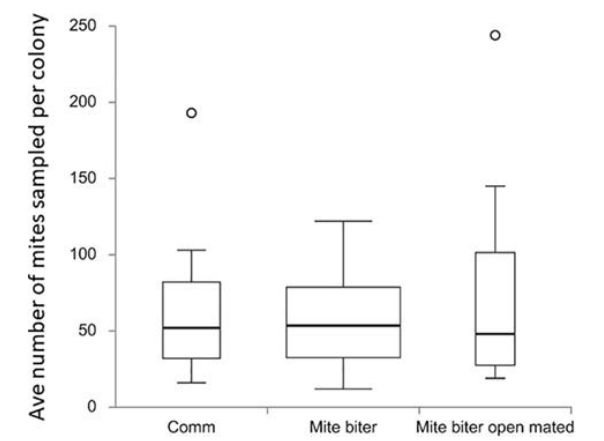
FIGURE 3 | Box plots of the average number of mites collected per colony among the three groups: commercial colonies (Comm, N colony = 15), Indiana mite-biter colonies (mite biter, N colony = 59), and open-mated mite-biter colonies (open-mated mite biter, N = 7). The open circles are outliers of the colonies, F (2,80) = 1.20, p = 0.31. The p -value corresponding to the F -statistic of the one-way ANOVA suggests that the three treatments were not significantly different.